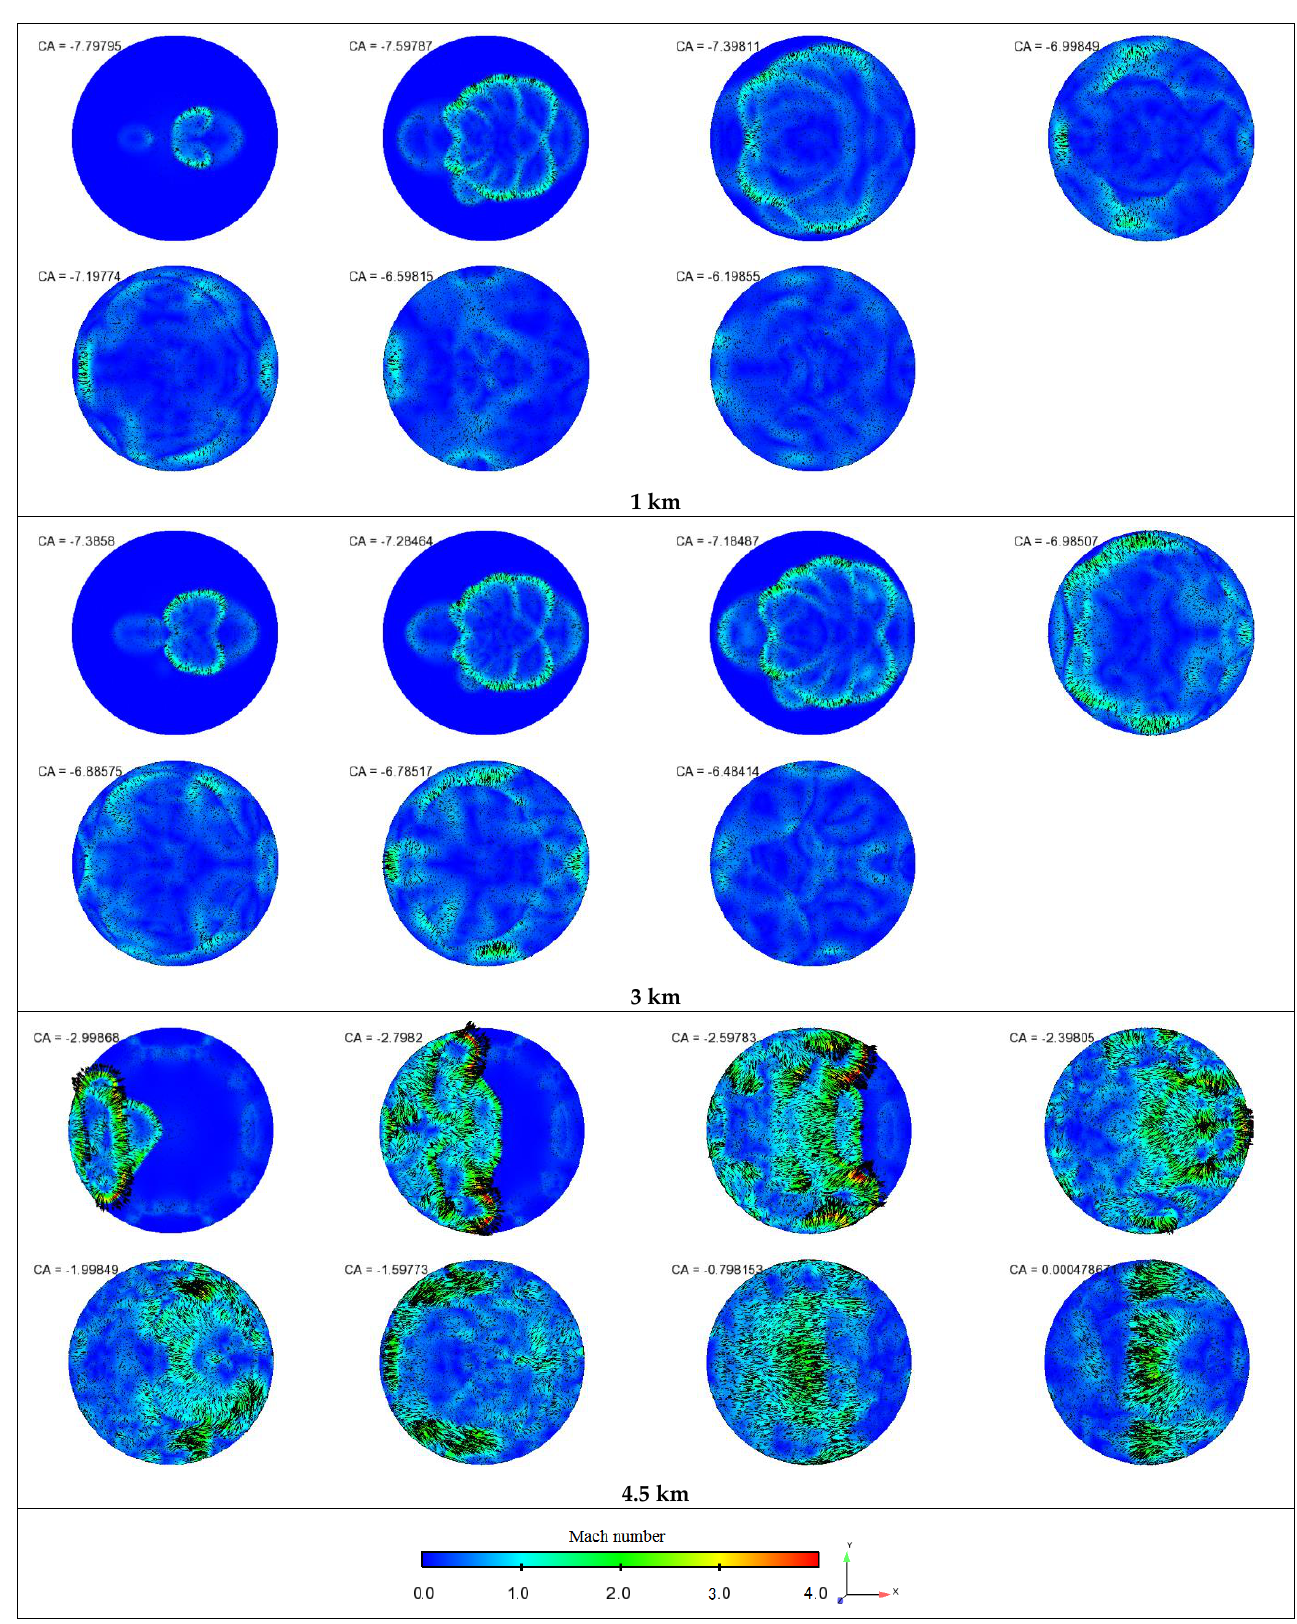
Figure 13. Comparison of flow velocity distribution at various altitudes.